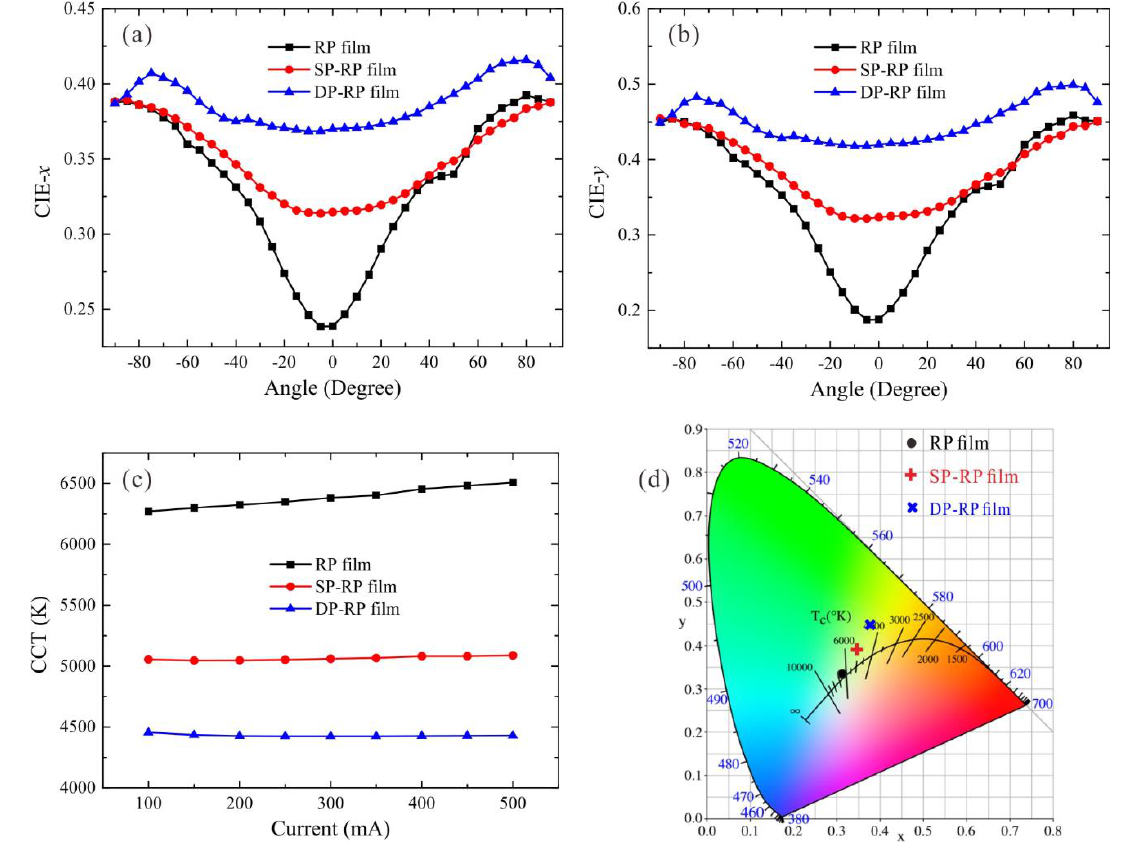
Figure 3. ( a ) Angle-dependent CIE-x and ( b ) CIE-y distributions of three rpc-LED devices at 300 mA measured in the angular range from −90° to 90°; ( c ) current-dependent CCT distributions and ( d ) the chromaticity coordinates in the CIE-1931 diagram of three rpc-LED devices at 300 mA.